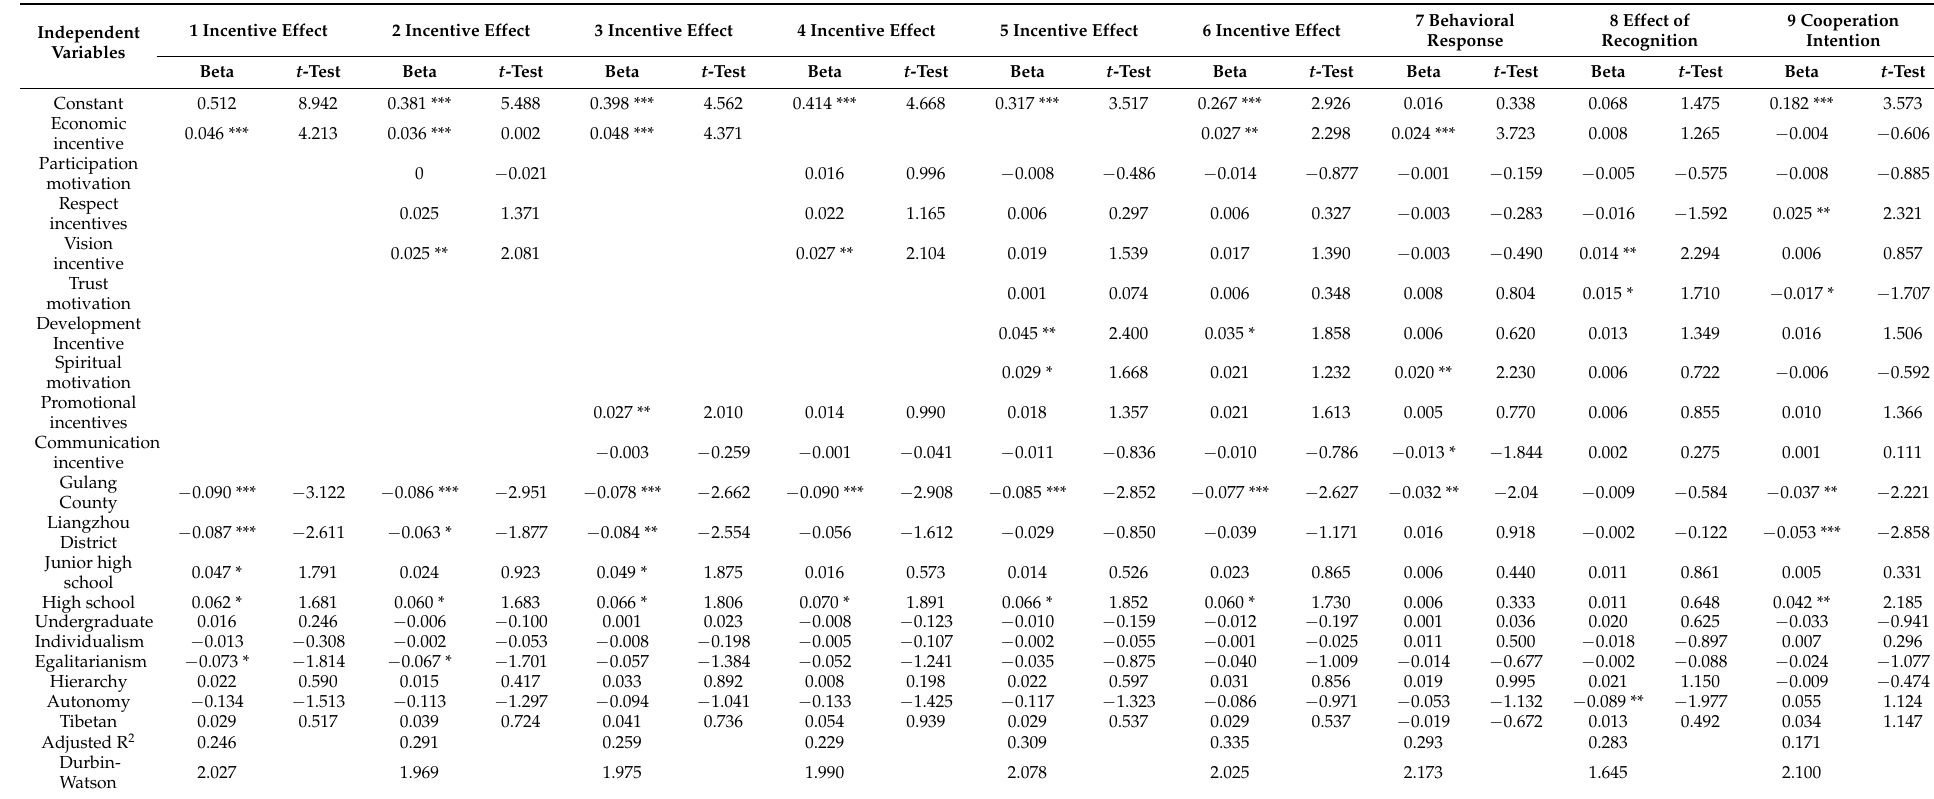
Table 3. The impact of motivation factors of economy on incentive effect of